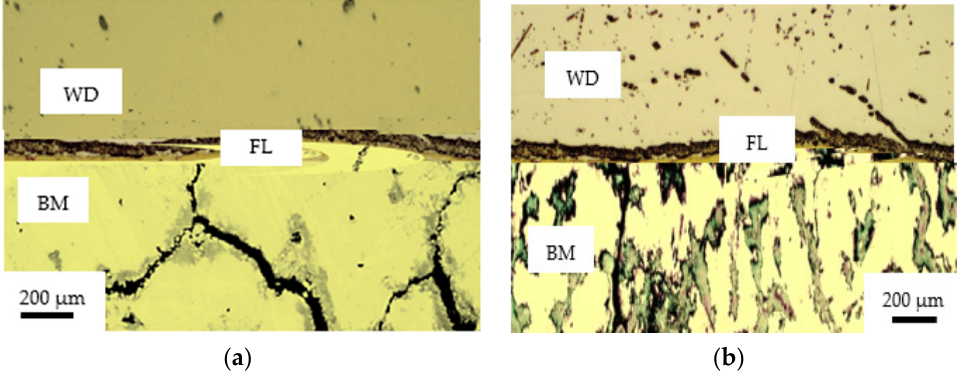
Figure 8. The metallographic structure of the transition area between the metal deposited by welding and the base material: ( a )—the metallographic structure in case of cold plating welding of the trimming die; ( b )—metallographic structure in case of hot plating welding of the trimming die.